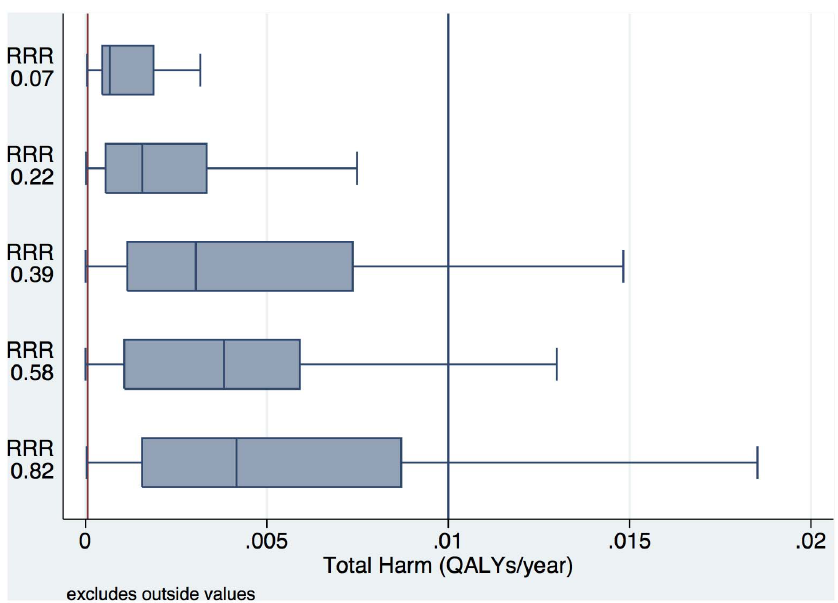
Figure 7. Multi-way sensitivity analysis: Relationship of Treatment Effect and Average Harm. Each box plot represents the distribution of total harm (probability of harm times the magnitude of harm 5 totally QALYs/ year lost to harm in treated patients) across quintiles of treatment benefit, represented with the average relative risk reduction in that quintile. The least beneficial simulations are displayed at the top (RRR 5 0.07) and the most beneficial trials at the bottom (RRR 5 0.82). The red line represents the approximate net harm of aspirin per year (probability of harm 5 0.001, magnitude of harm 5 0.06 QALYs) and the blue line represents a theoretical medication with a more harm profile (probability of harm 5 0.001, magnitude of harm 5 10 QALYs or probability of harm 5 0.01, magnitude of harm 5 1 QALY).